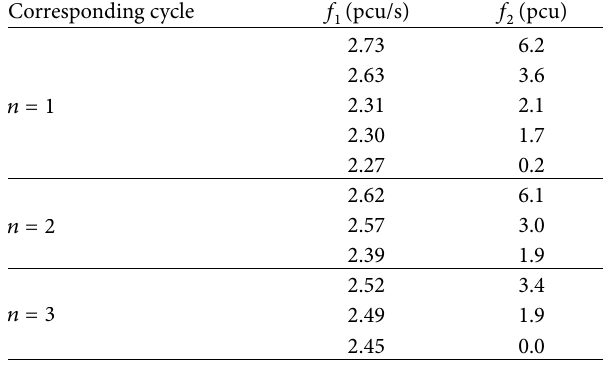
is 10 o’clock. 0